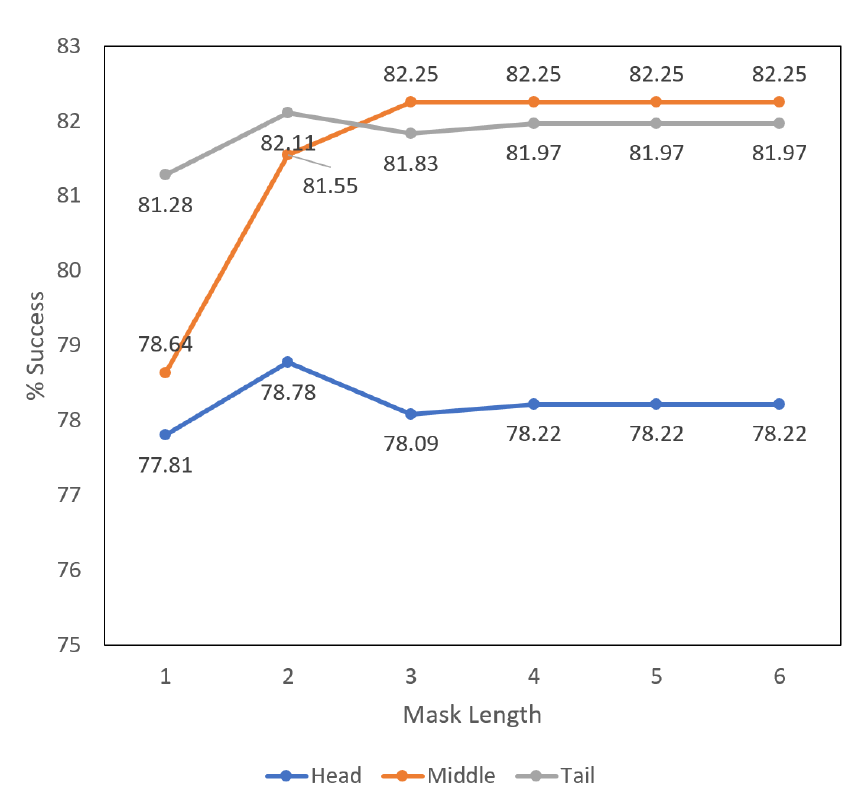
Figure 3. The Influence of mask length. The target model is CNN trained with